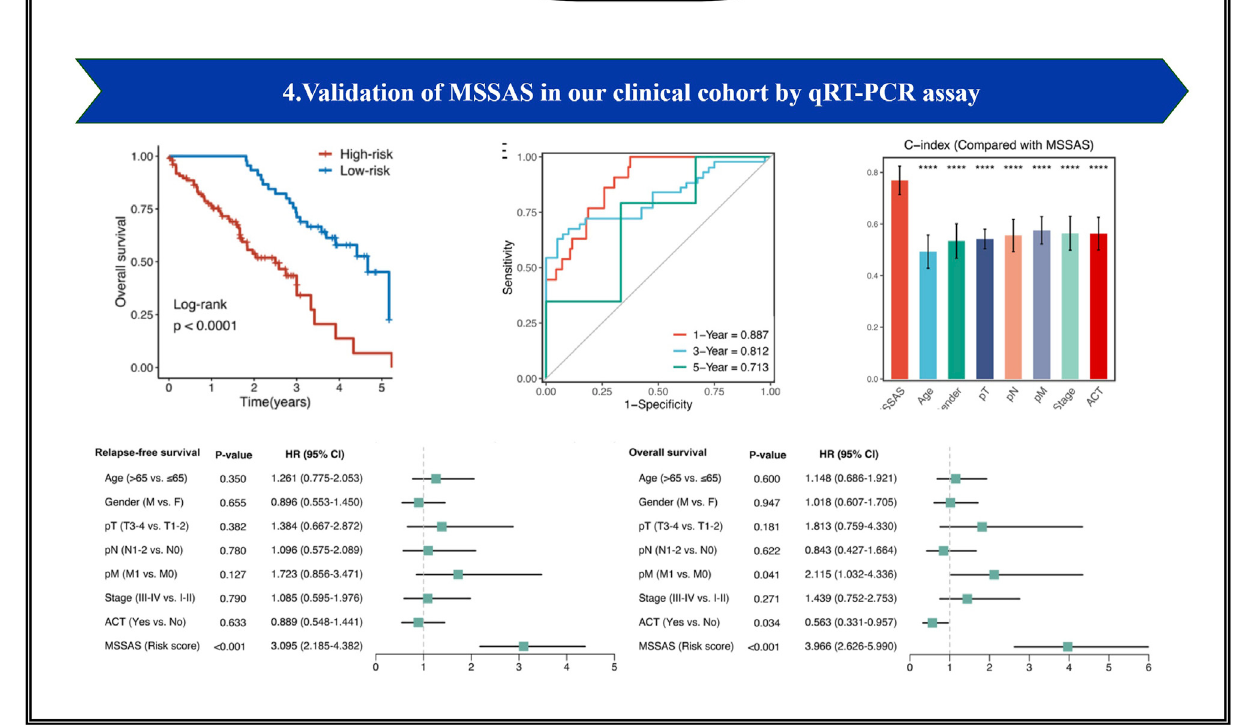
Frontiers in Cell and Developmental Biology | www.frontiersin.org February 2022 | Volume 10 | Article 790214